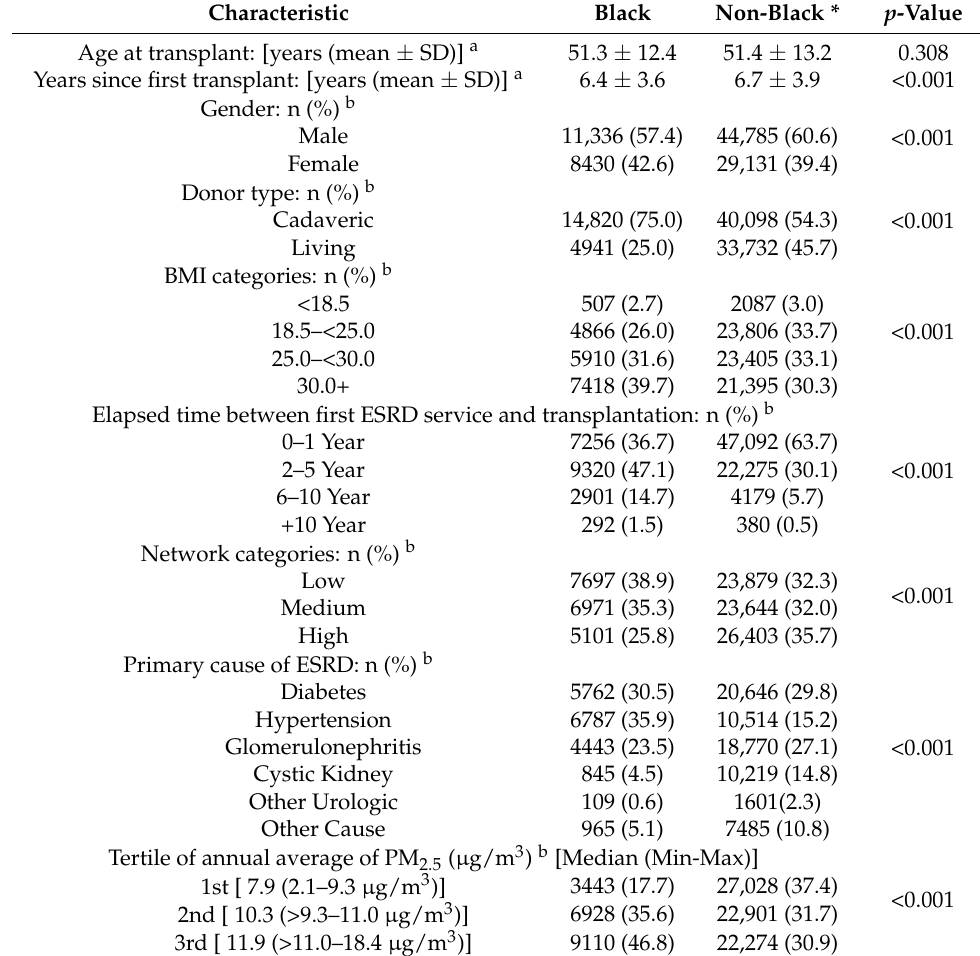
Table 1. Demographic and Health Characteristics of Overall Study Cohort According to